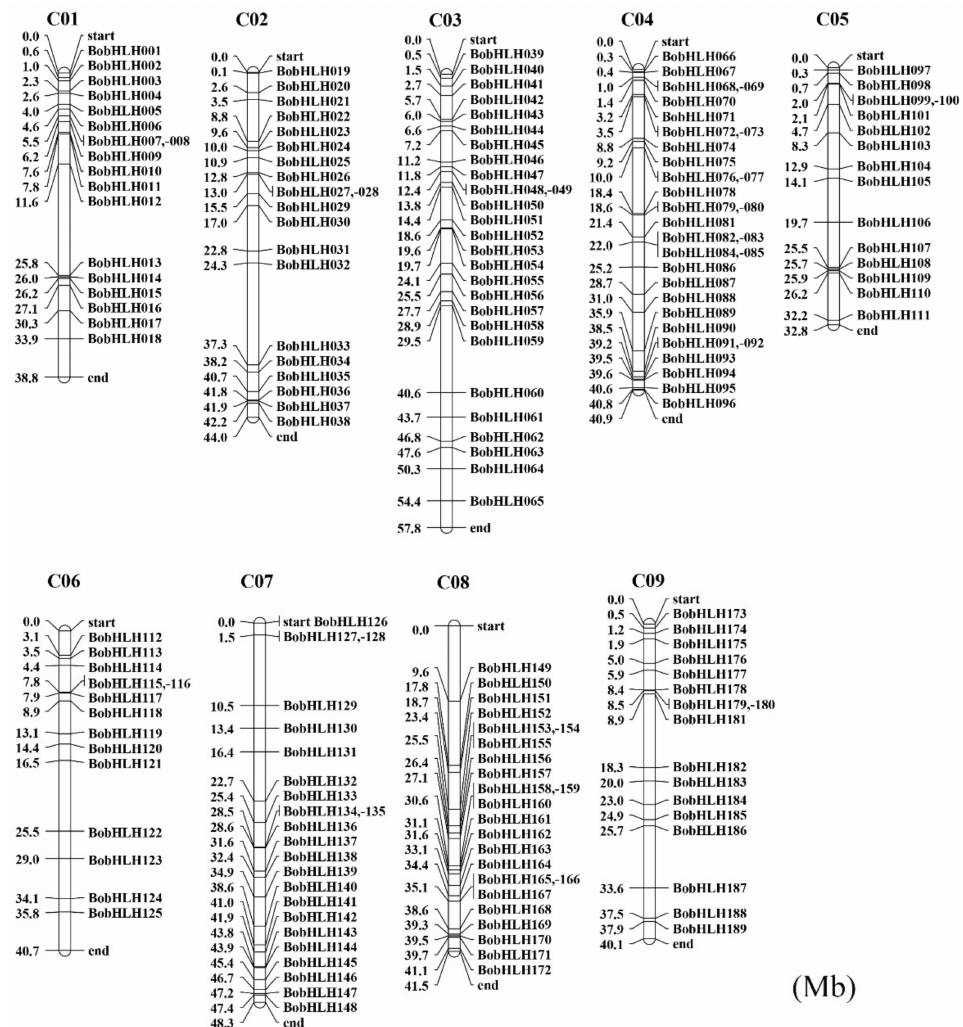
Figure 2. Distribution of BobHLH genes on nine B. oleracea